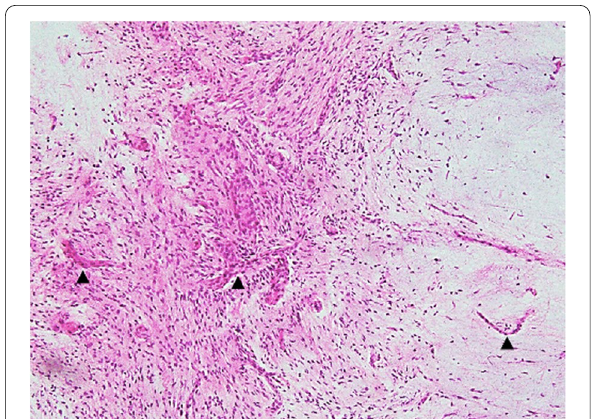
Fig. 3 Alternating myxoid and cellular spindle shaped cells with occasional curvilinear-like blood vessels (arrow head) (hematoxylin and eosin stain, original magnification ×